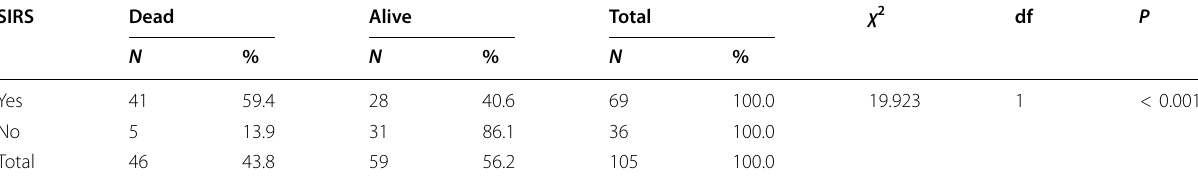
Table 3 SIRS among the study population